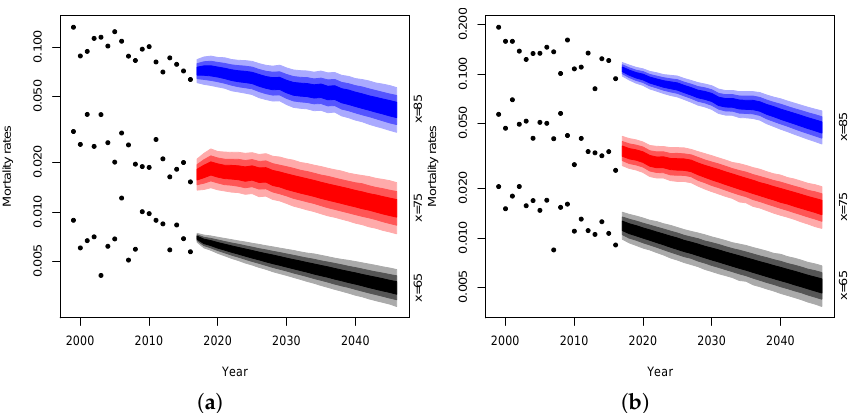
Figure A1. Mortality rate projections at age 65, 75, 85 with Plat–LC model (best ARIMA processes) for ( a ) female Maltese population, ( b ) male Maltese